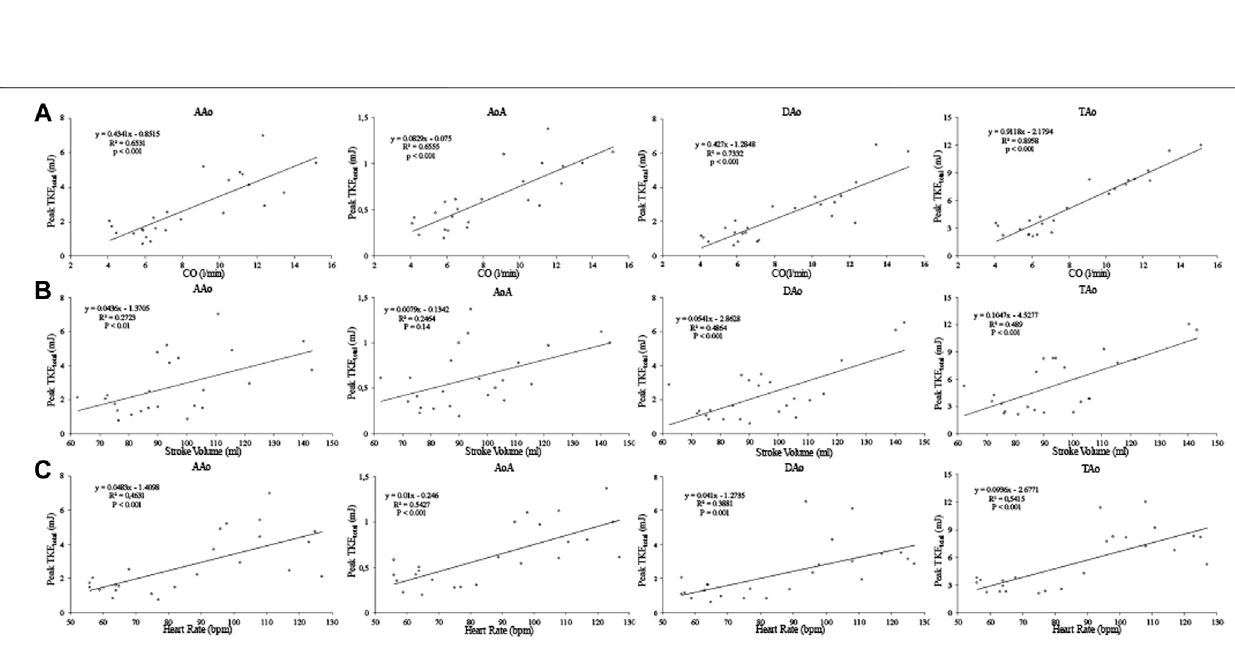
FIGURE 6 | Regression analysis between Peak TKE total and CO (A) , left ventricular stroke volume (B) , and heart rate (C) for the four aortic regions. Values at rest andwithdobutamineinfusionfromeachhealthysubjectareincluded.CO,cardiacoutput;AAo,ascendingaorta;AoA,aorticarch;DAo,descendingaorta;TAo,thoracic aorta ( Supplementary Video